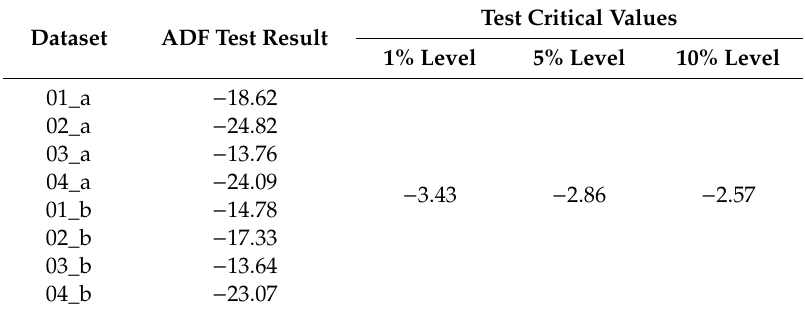
Table 6. Stationary tests for noise time series of di ff erent sampling points and monitoring